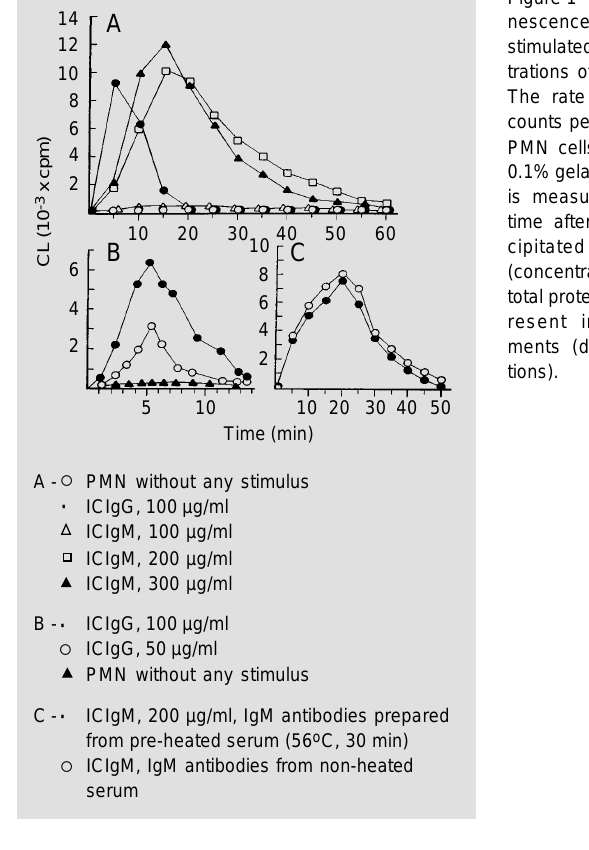
Figure 1 - Kinetics of chemilumi- nescence production by PMN stimulated with various concen- trations of ICIgG and of ICIgM. The rate of CL generation in counts per min (cpm) of 2 x 10 6 PMN cells in 2 ml HBSS (with 0.1% gelatin and 10 -7 M luminol) is measured in the course of time after incubation with pre- cipitated immune complexes (concentrations expressed as µg total protein/ml). A, B and C rep- resent independent experi- ments (different cell prepara- tions).